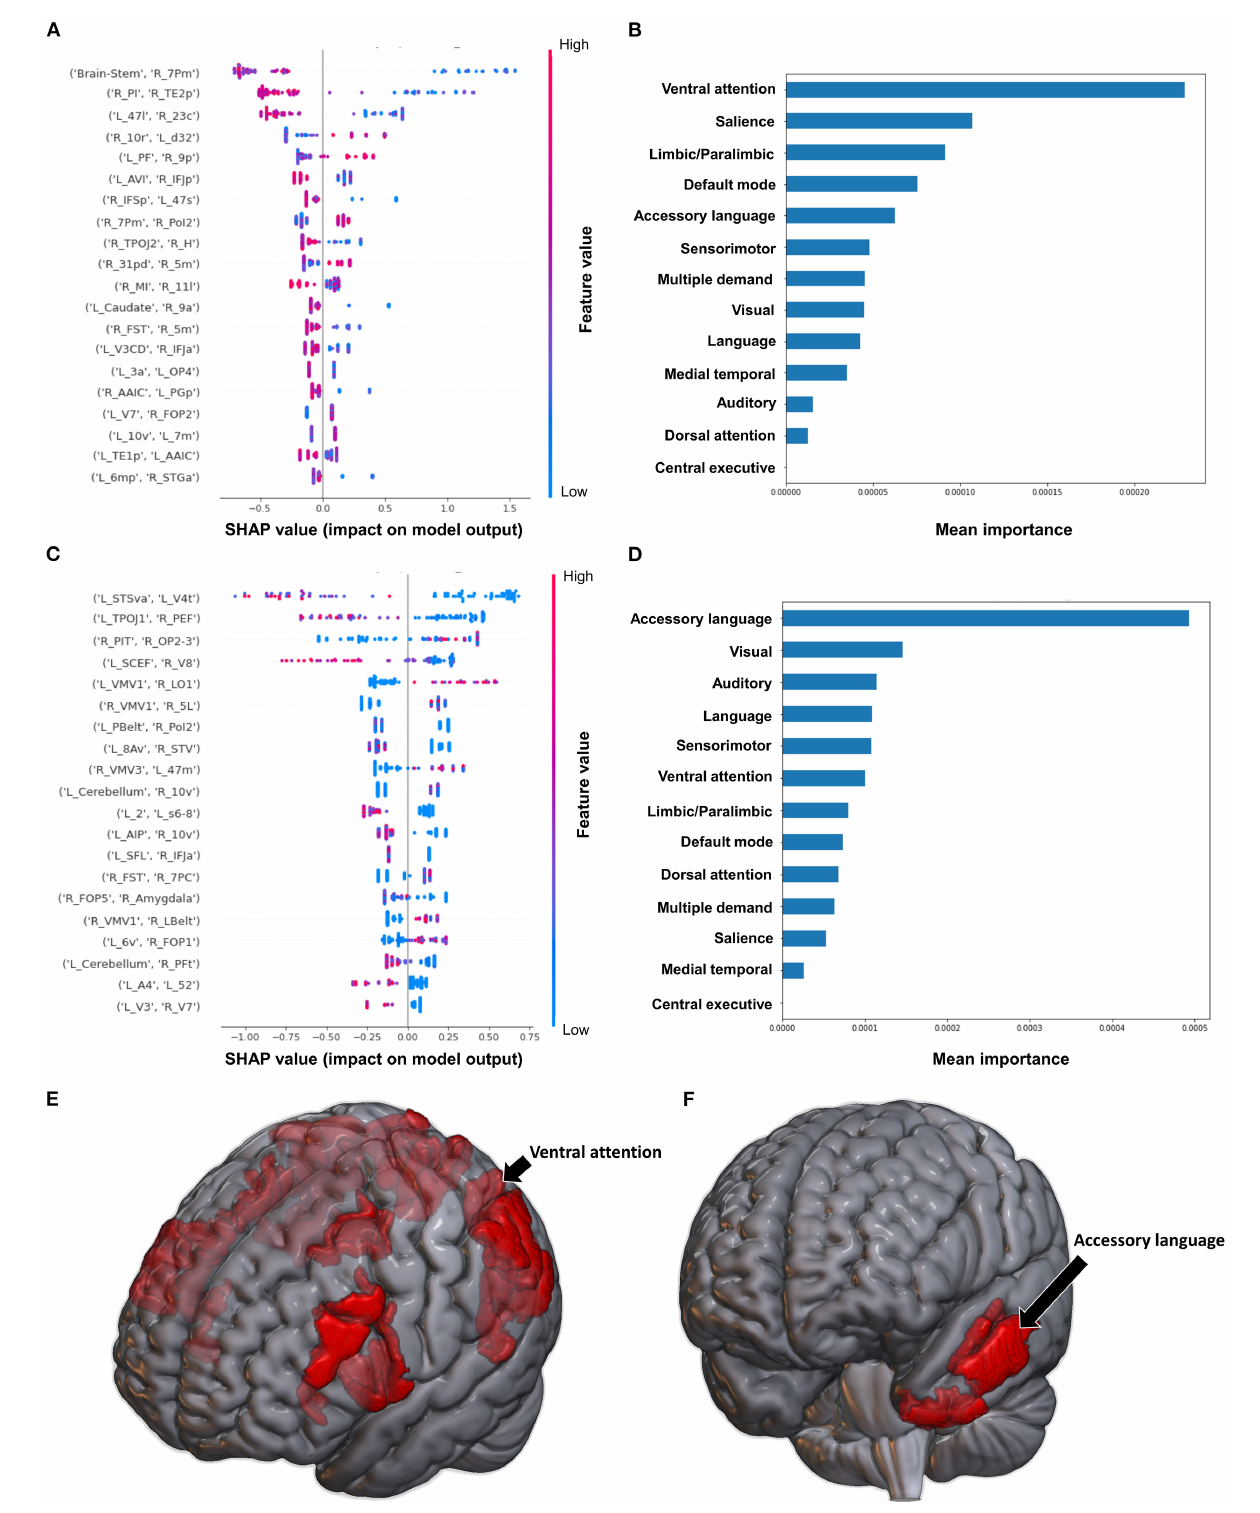
FIGURE6 Feature Importance Analysis of the models classifying the Barthel index based on functional connectivity at the (A) individual brain region level, and (B) the network level; and based on structural connectivity at the (C) the individual brain region level, and (D) the network level. The networks contributing most to the models’ classifications, based on (E) functional connectivity, and (F) structural connectivity, have also been visualized on brain